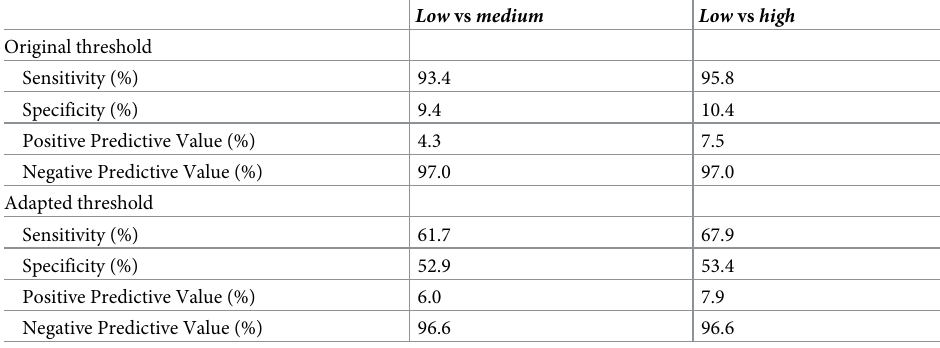
Table 4. Performance measures with which the model classifies patients into the different risk groups.